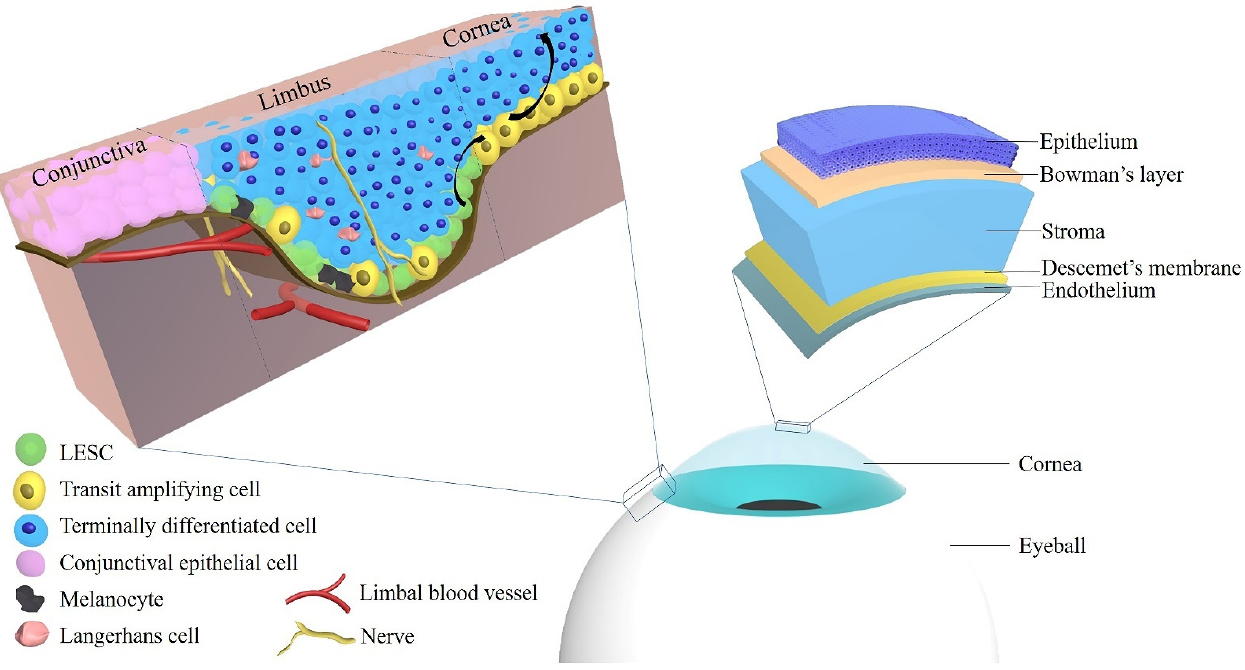
Figure 1. The localization of limbal epithelial stem cells and the anatomy of the cornea. Abbreviations: LESC: limbal epithelial stem cell.